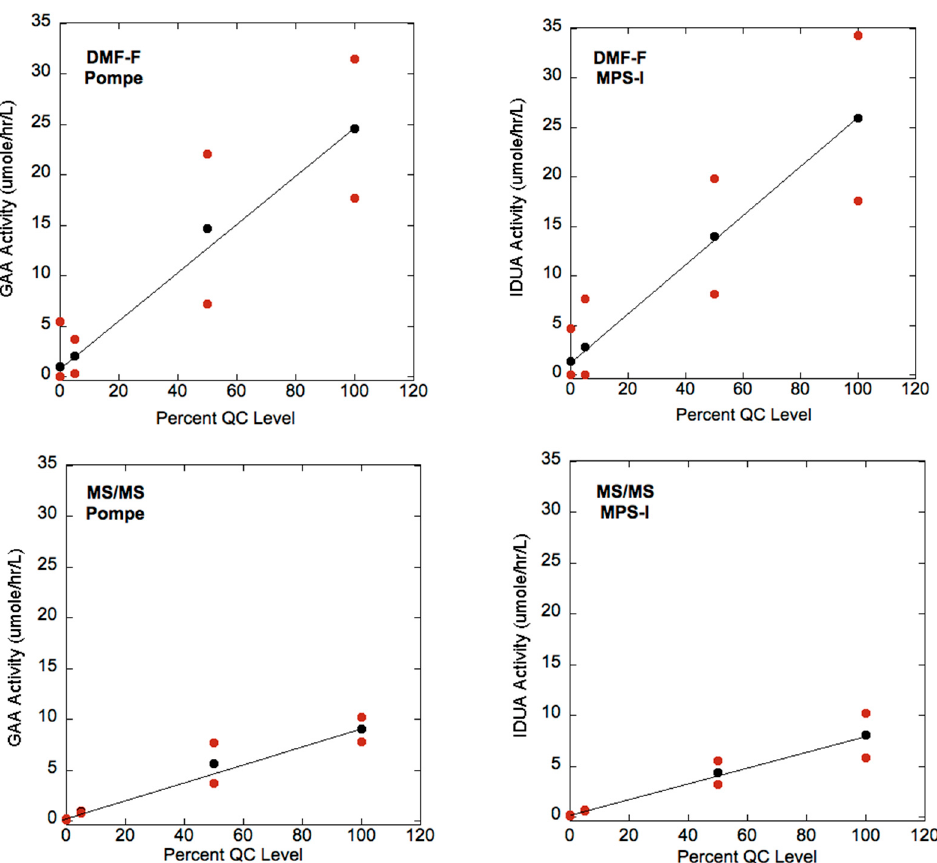
Figure 1. Plots of the precision data taken from the certificate reports for the Centers for Disease Control and Prevention (CDC) quality control DBS for GAA (Pompe disease) and alpha-iduronidase (IDUA, MPS-I) using either DMF-F or MS/MS (reports provided as Supplemental Material). The CDC carried out repetitive assays using either DMF-F or MS/MS with 10 punches from each quality control DBS. Plotted is the mean enzymatic activity (black dots) for the BASE sample (0 % QC level), the LOW sample (5% QC level), the MEDIUM sample (50% QC level), and the HIGH sample (100% QC level). The red dots are the 95% upper and lower confidence intervals.